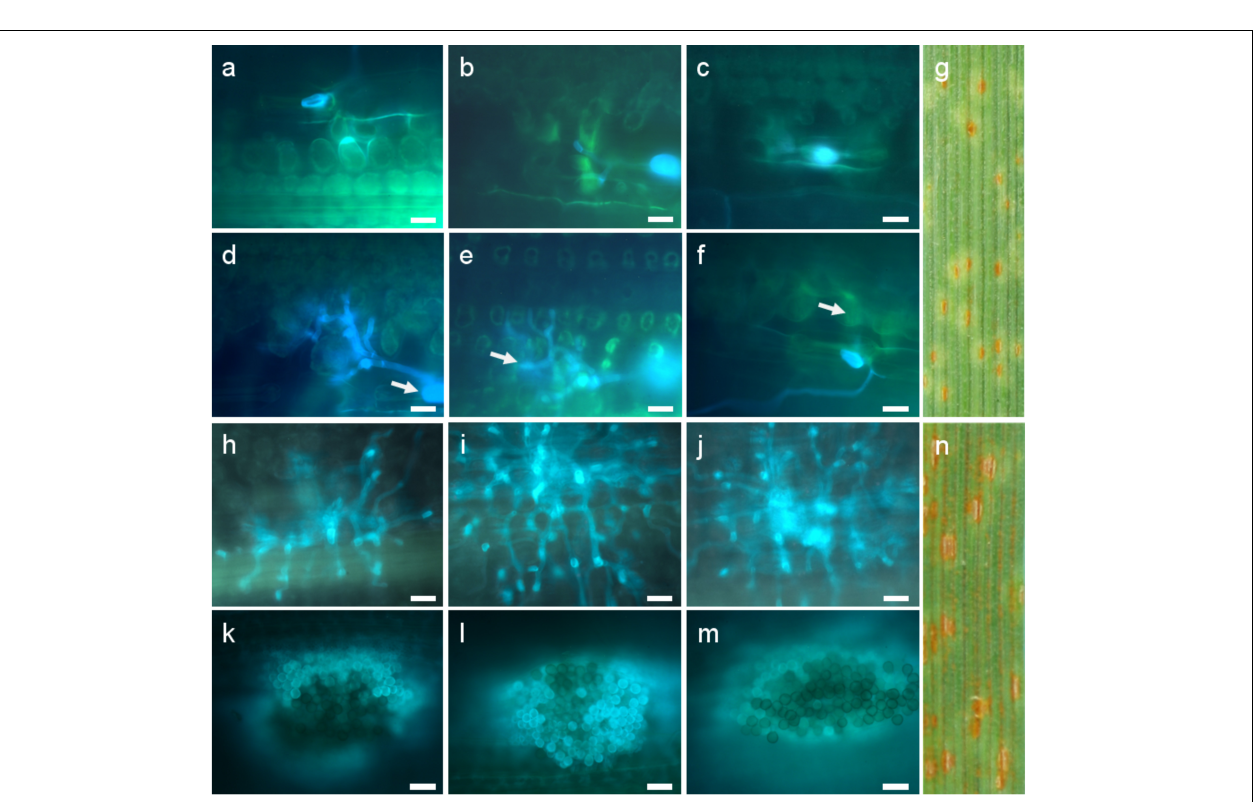
FIGURE 3 | Statistical analysis of macroscopic reaction of hybrids carrying leaf rust resistance genes (hybrids) and control plants (controls) inoculated with single spore isolates at 168 hai at the seedling and adult plant stage. The bars represent a mean value (over replications) and error bars represent standard errors. The letters indicate homogenous groups of means that do not differ significantly at a significance level of 0.05 (Fisher’s LSD-test).